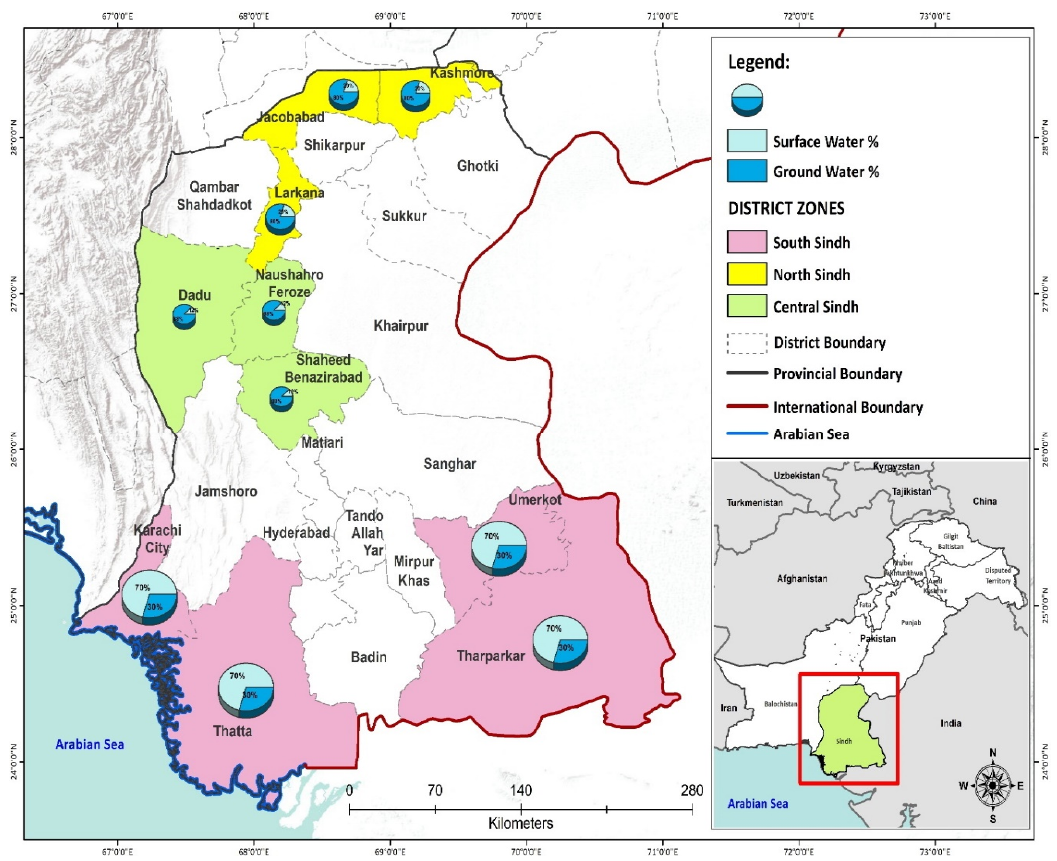
Figure A1. Water source distribution by zones and provincial boundaries.